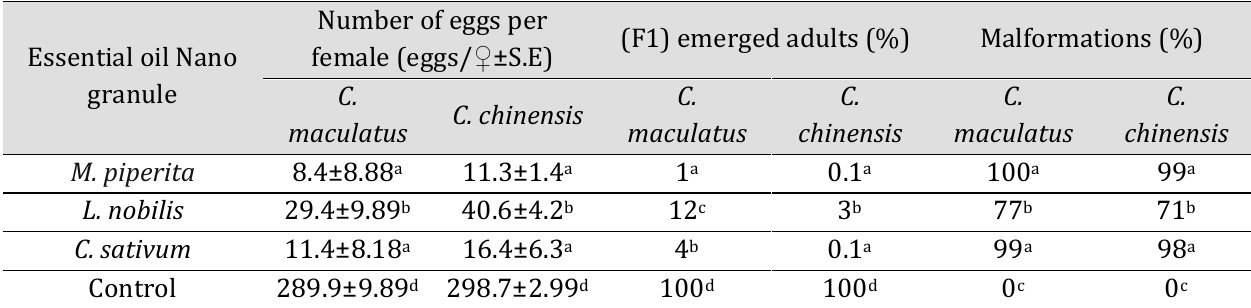
Table 2. The ovipositional activity inhibitory effect of essential oils Nano granules against C. maculatus and C.